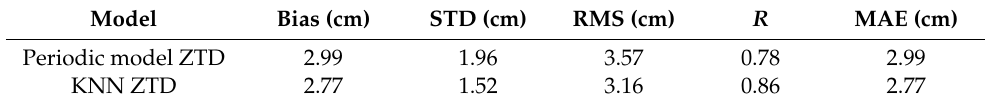
Table 2. Accuracy comparison between the KNN and the periodical model for data gap interpolation.